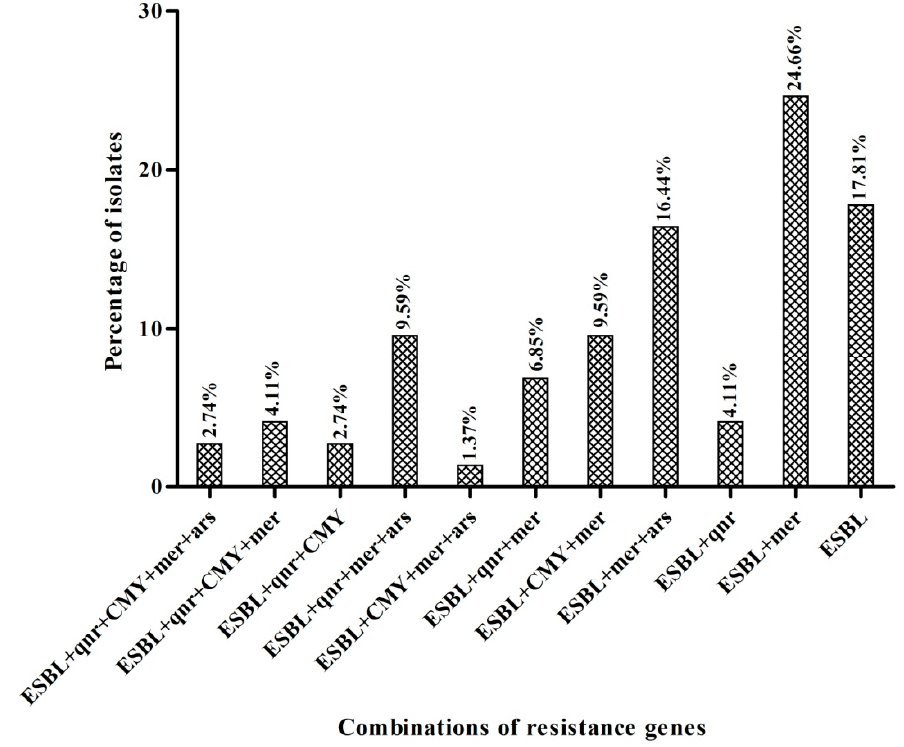
Figure 2. Percentage of bacterial strains harboring different resistance genes.